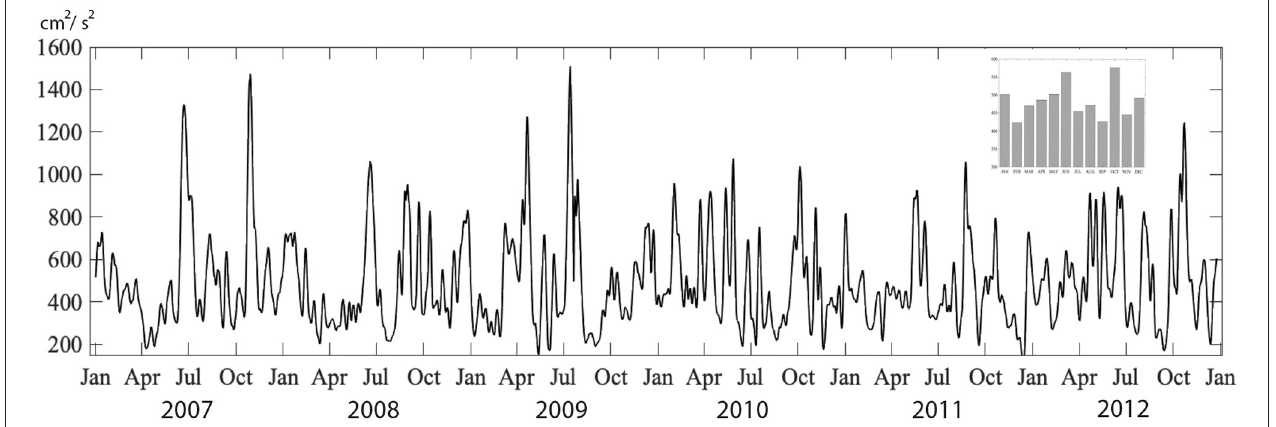
FIGURE 3 | Spatially averaged (over La Guajira, see black box in Figure 1A ) Eddy Kinetic Energy, < K e > between 2007 and 2012. For the sake of clarity a 10-day smoothing has been applied. In the inset panel, the 6-year (2007–2012) monthly mean spatially averaged Eddy Kinetic Energy is shown with bars to better display the semi-annual cycle.